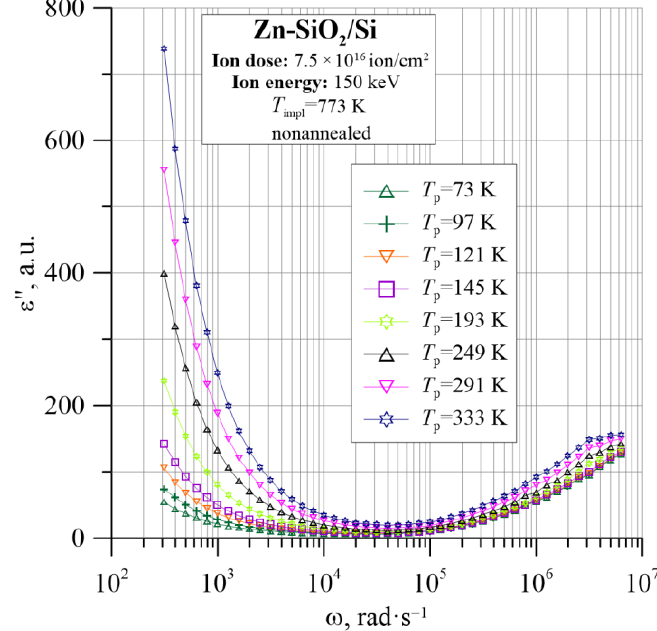
Figure 6. Temperature dependence of the imaginary part of dielectric permittivity ε” for the Zn- SiO 2 /Si nanocomposite immediately after preparation under “hot” implantation conditions (150 keV, 7.5 × 10 16 ion/cm 2 , T impl = 773 K).